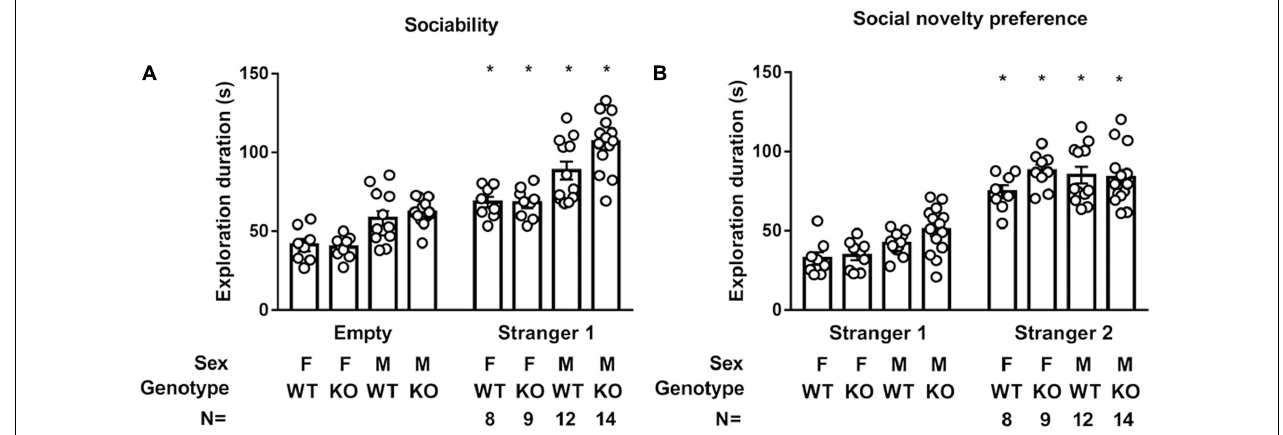
FIGURE 8 | SEPT14 KO and sociability and social novelty preference. (A) While all four groups of mice spent higher exploration duration on stranger 1 than on empty cage [ F (1,78) = 112.9, p < 0.0001], male mice spent higher total exploration duration toward stranger 1 and empty cage as compared to female mice [ F (1,39) = 45.31, p < 0.0001]. *Significantly higher than their exploration duration with an empty cage ( p < 0.05). (B) All four groups of mice spent higher exploration duration on stranger 2 than previously met stranger 1 [ F (1,78) = 198.7, p < 0.0001]. *Significantly greater than their exploration time with stranger 1 cage ( p < 0.05). Male mice spent higher total exploration duration to stranger 1 and 2 cages as compared to female mice [ F (1,39) = 4.798, p = 0.0345]. The bar and error bar represent group mean and SEM,